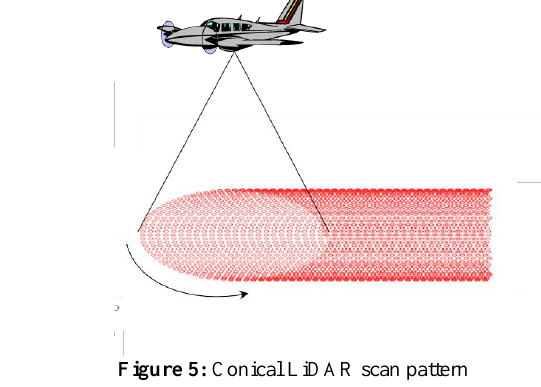
Figure 5: Conical LiDAR scan